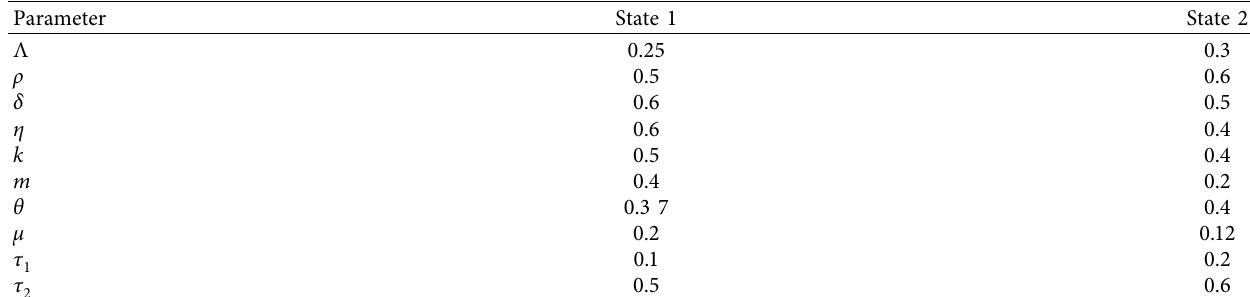
Figure 4: The effects of the validity period τ Table 2: Parameters value used in simulation of model